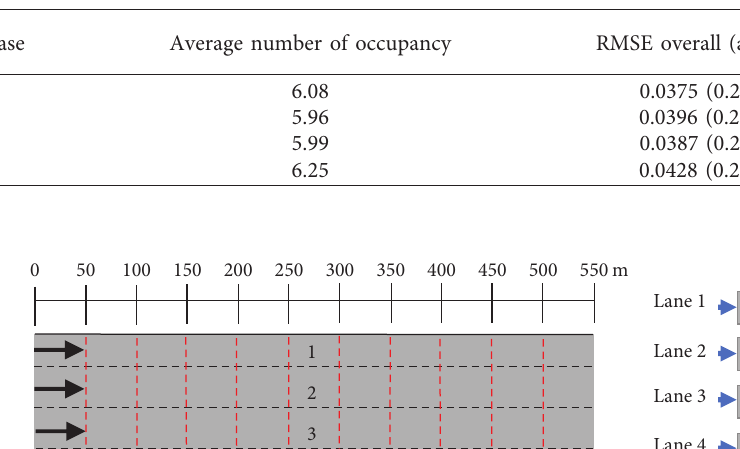
Table 1: Comparison of the statistical test between Cases 1–4.